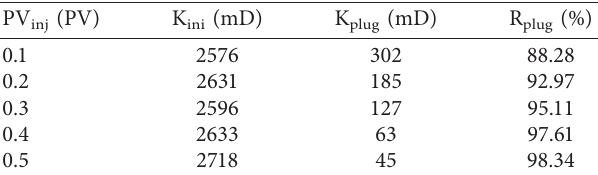
Table 2: Plugging effect experiments with different sand pack models.